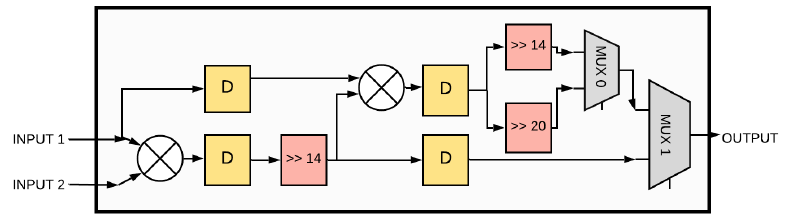
Figure 13. Multiplication module. D represents one clock cycle delay.